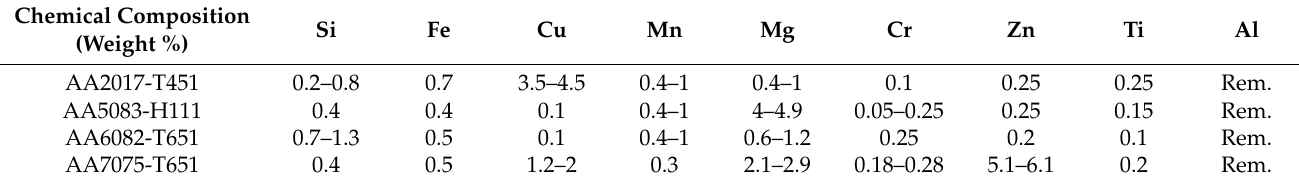
Table 2. Chemical composition of the aluminium alloys (weight